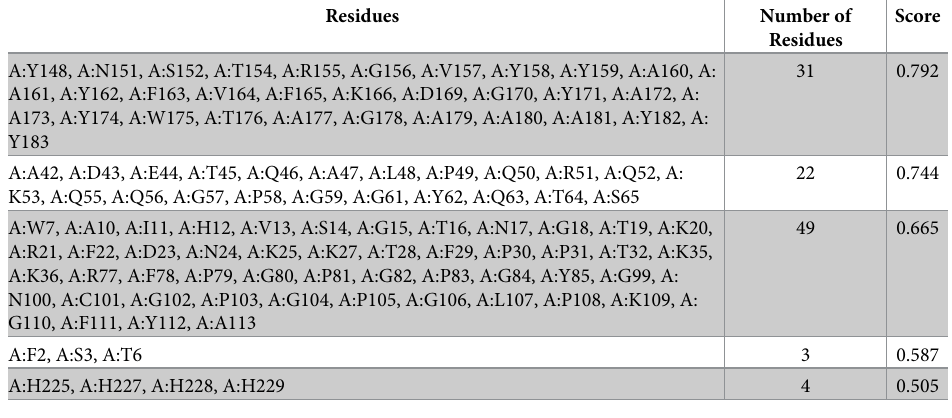
Table 3. Prediction of discontinue B-cell epitopes in the designed S-N-M multiepitope peptide. Residues Number of Residues